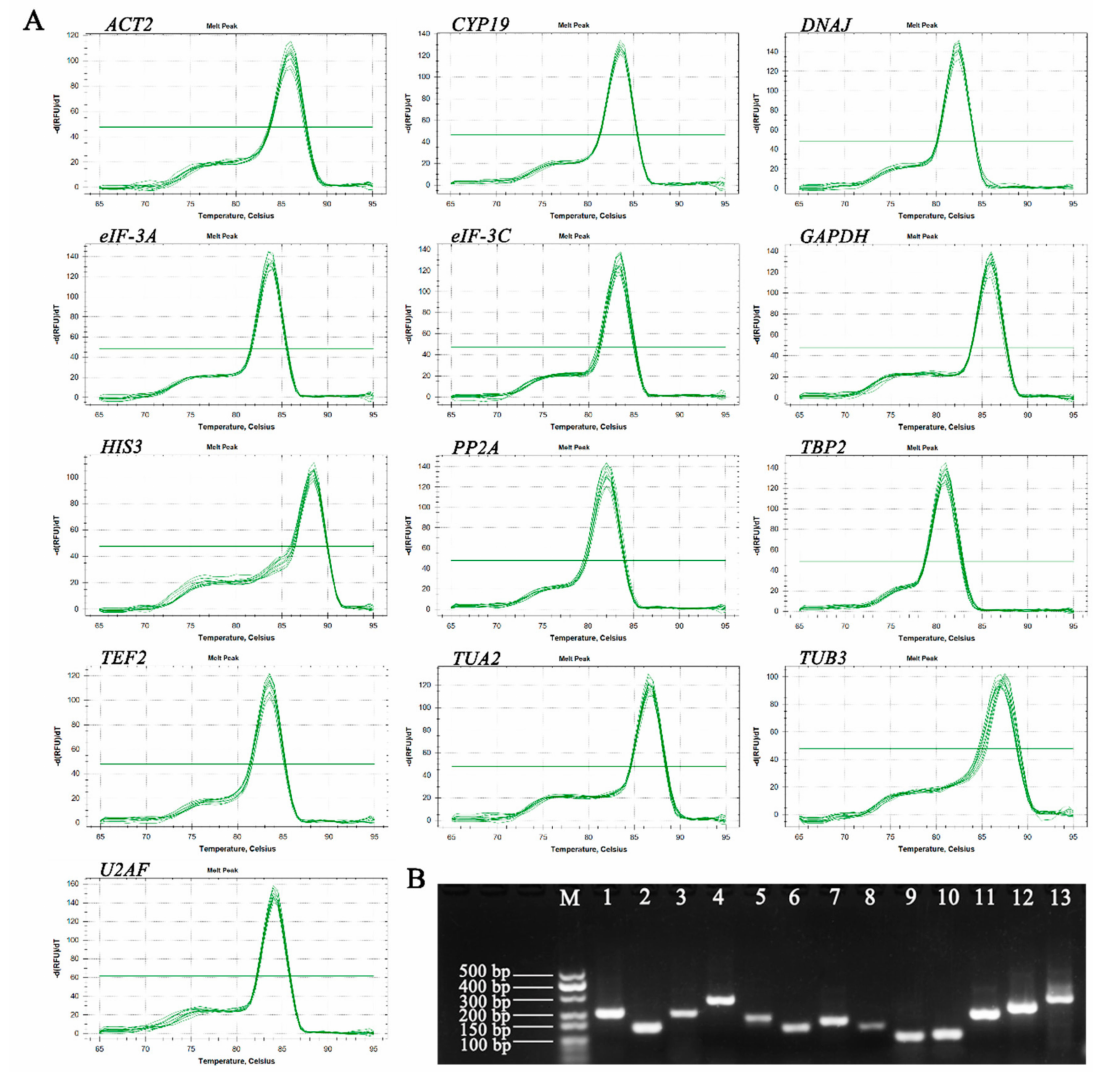
Figure 1. Primer specificity and amplicon size of 13 candidate reference genes. ( A ) Melting curves of 13 candidate reference genes exhibiting single peaks. ( B ) Agarose gel electrophoresis (2%) showing specific amplification products of expected size using Real Time-qPCR. M: 500 bp marker. 1–13: ACT2 , CYP19 , DNAJ , eIF-3A , eIF-3C , GAPDH , HIS3 , PP2A , TBP2 , TEF2 , TUA2 , TUB3 , and U2AF